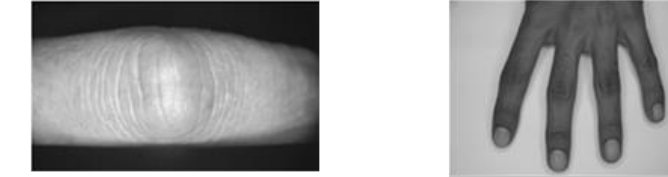
Figure 6. Sample of images taken from ( left ) [8], ( right )